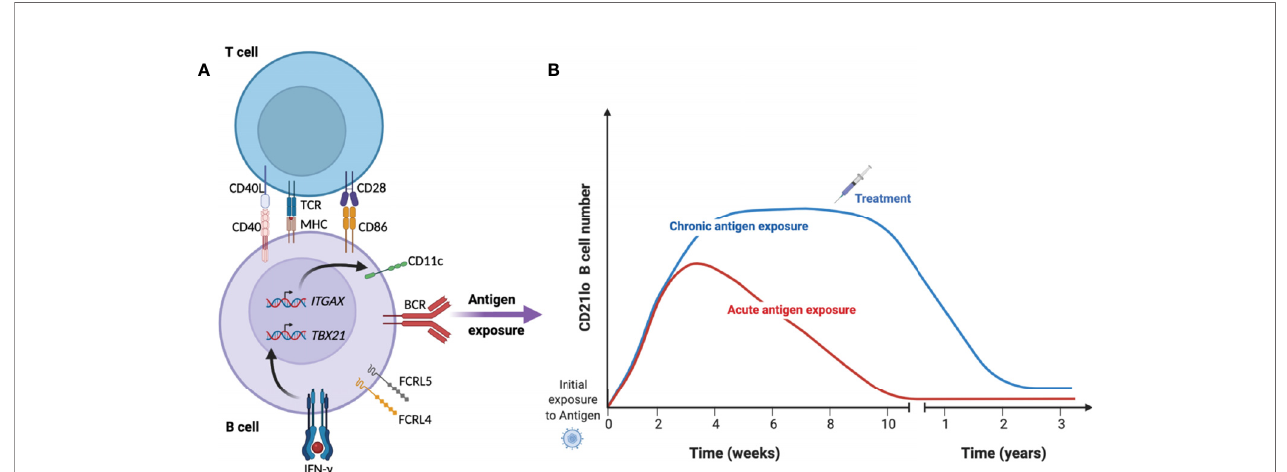
FIGURE 1 | Kinetics of CD21 lo CD11c + T-bet + B cells during acute and chronic disease. (A) Under speci fi c conditions such as B cell receptor (BCR) activation in the presence of IFN- g and T cell help, B cell will acquire a phenotype characterized by reduced expression of CD21 and increased expression of CD11c ( ITGAX ), T- bet ( TBX21 ) and FCRL4/5. (B) They then rapidly expand over several weeks until they start to contract over several months in the absence of antigen (red line). In the context of chronic infection or repeated infection (blue line), the cells can remain a substantial proportion of total B cells until treatment removes the source of antigen and reduce the in fl ammatory